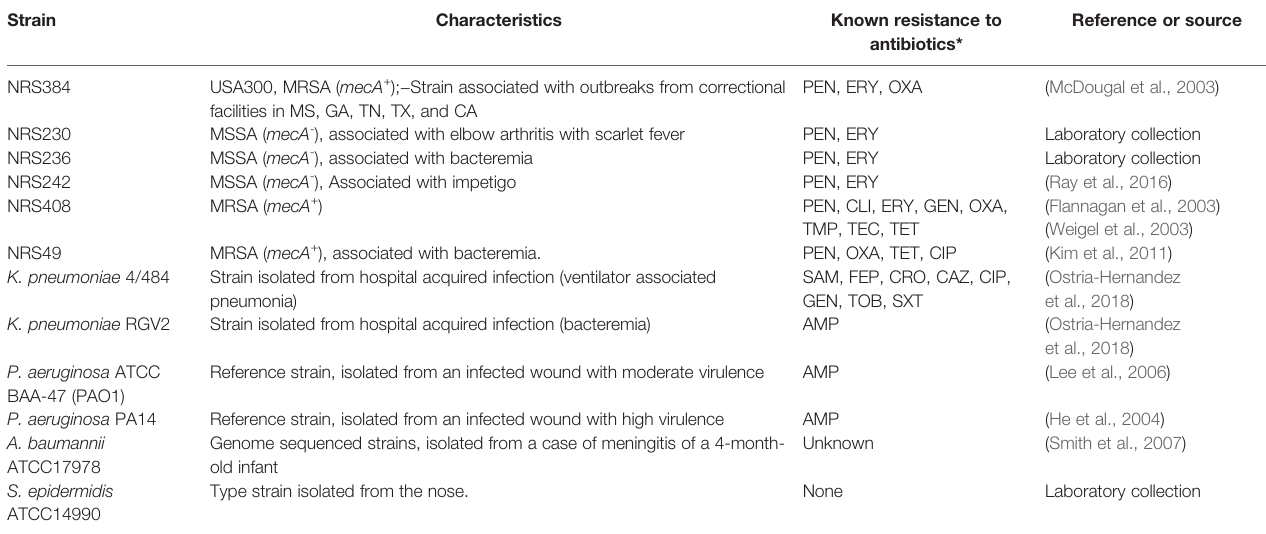
TABLE 1 | Bacterial strains utilized in this